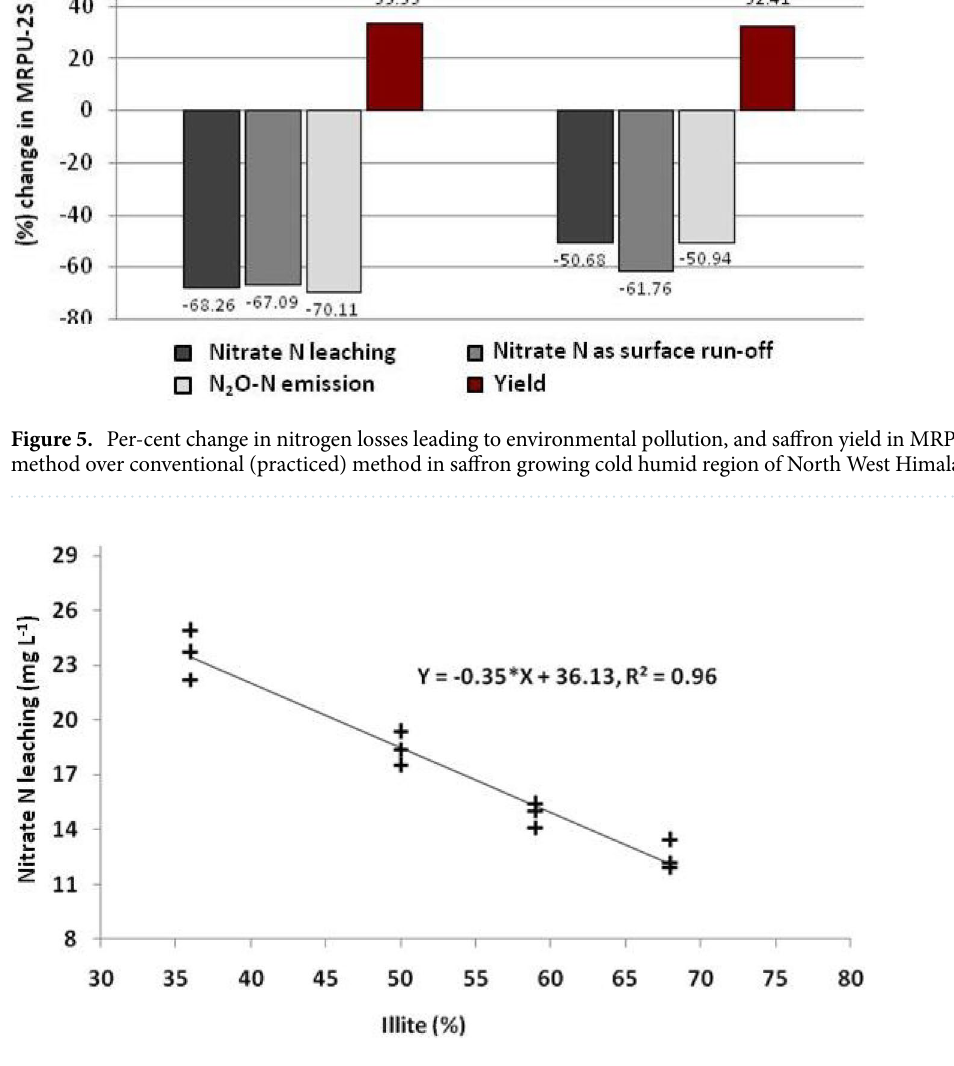
Figure 6. Nitrate N leaching as influenced by illite content in saffron growing cold humid region of North West